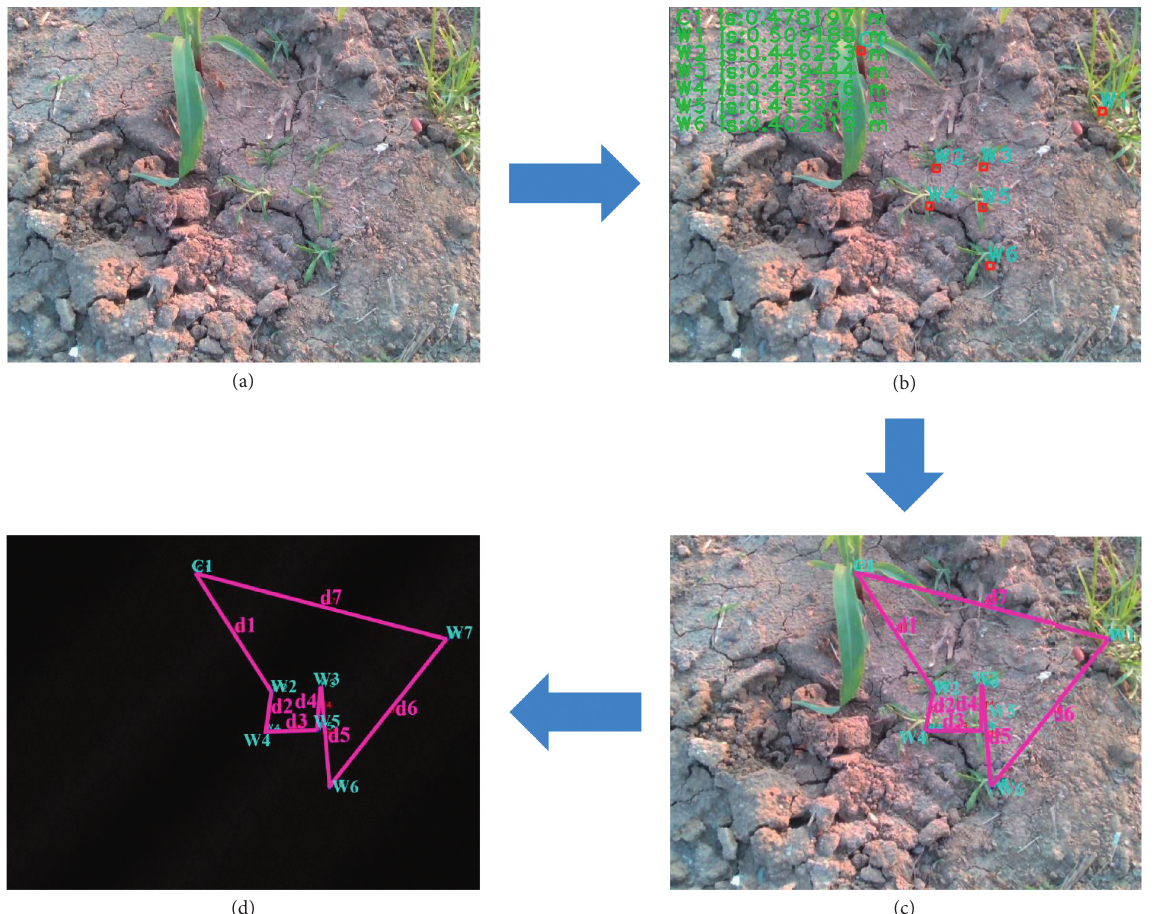
Figure 12: Schematic diagram of the target depth ranging and the shortest path planning. (a) Keyframe image of depth camera; (b) multitarget ranging result image; (c) shortest weeding path planning result image; and (d) the shortest weeding path extracts the rendered